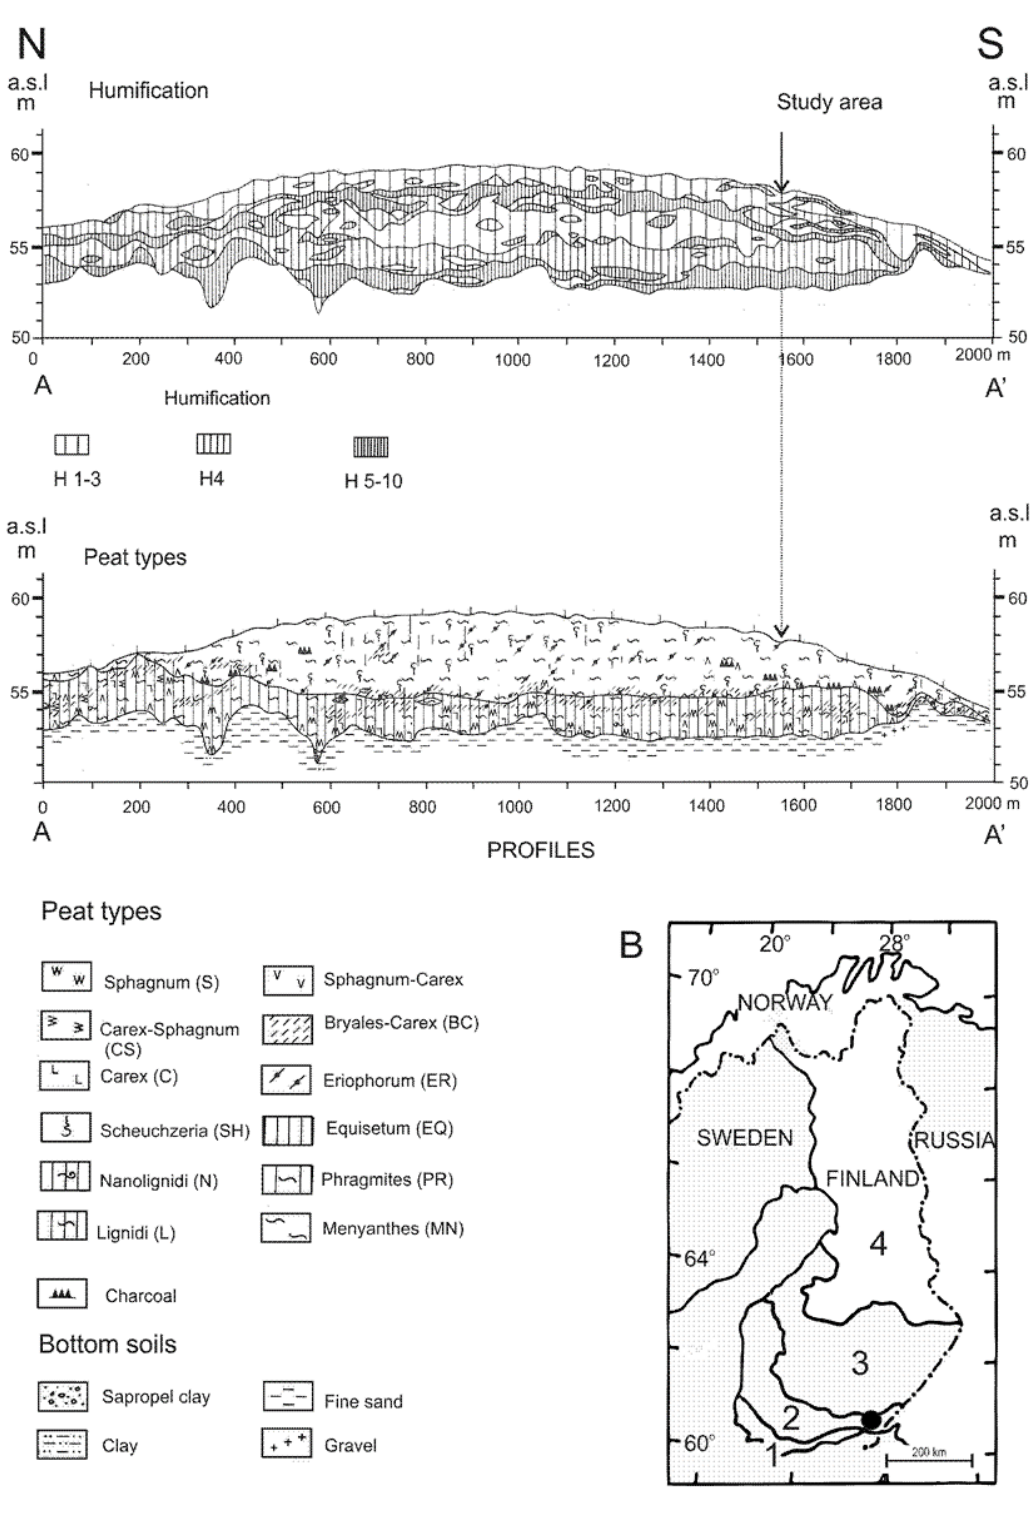
Figure 2. A: Cross-section of the Haukkasuo raised bog massif along the main transect described by Mäkilä (1997) showing humification (upper diagram) and peat types (lower diagram). The main transect passes through the centre of the bog in a north-south direction. The study area for the work described here, containing Study Sites A 1550 and A 1585, was located near this main transect at the point indicated (see also Figure 1). B: Map showing the location of Haukkasuo (large black dot) in south-eastern Finland, relative to the zones of mire complex types: 1 - plateau bogs, 2 - concentric bogs, 3 - eccentric and Sphagnum fuscum bogs, 4 - aapa mires (after Ruuhijärvi